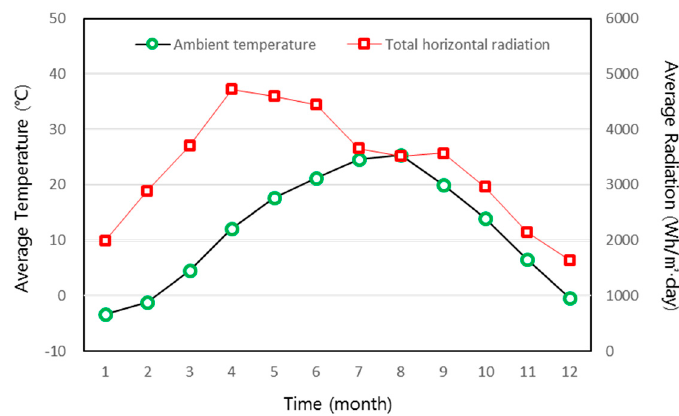
Figure 10. Weather data in Seoul.